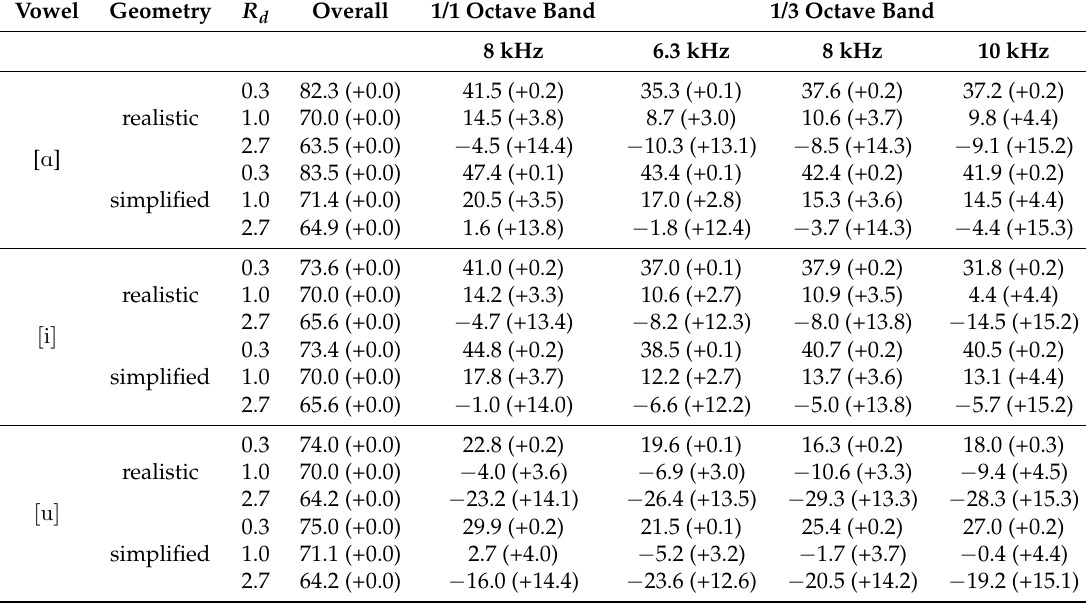
Table 1. Overall and high frequency energy (HFE) levels (in dB) obtained in the realistic and simplified vocal tract configurations of vowels [ A ], [i], and [u]. Values correspond to vowels with a tense ( R d = 0.3), a modal ( R d = 1), and a lax ( R d = 2.7) phonation without considering aspiration noise. The values in parentheses denote the increment in dB obtained due to adding aspiration